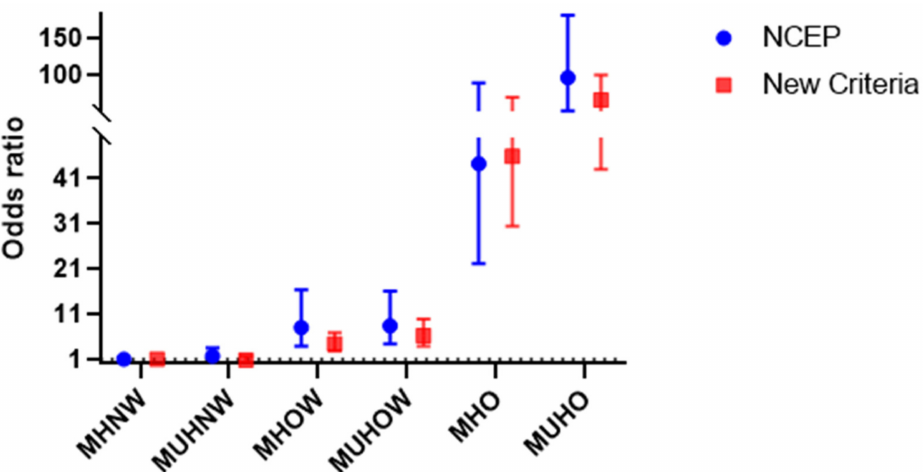
Figure 4. Risk of nonalcoholic fatty liver disease in subgroups of body mass index and metabolic health using the new definition (red square) and the National Cholesterol Education Program–Adult Treatment Panel III (NCEP-ATPIII) criteria (NCEP definition) (blue dot). Hazard ratios (95% CIs) adjusted for age, sex, HbA1c, TG, HDL-C, LDL-C, hsCRP, HOMA-IR, smoking status, AST, ALT, γ GTP, smoking status, alcohol consumption, physical activity, and the corresponding other defini- tion of metabolic health. Abbreviations: CI, confidence interval; hemoglobin A1c; TG, triglyceride; HDL-C, high-density lipoprotein cholesterol; LDL-C, low-density lipoprotein cholesterol; hs-CRP, high-sensitivity C-reactive protein; HOMA-IR, homeostatic model assessment for insulin resistance; ALT, alanine transferase; AST, aspartate aminotransferase; GGT, gamma glutamyltransferase; MHNW, metabolically healthy normal weight; MUHNW, metabolically unhealthy normal weight; MHOW, metabolically healthy overweight; MUHOW, metabolically unhealthy overweight; MHO, metaboli- cally healthy obese; MUHO, metabolically unhealthy